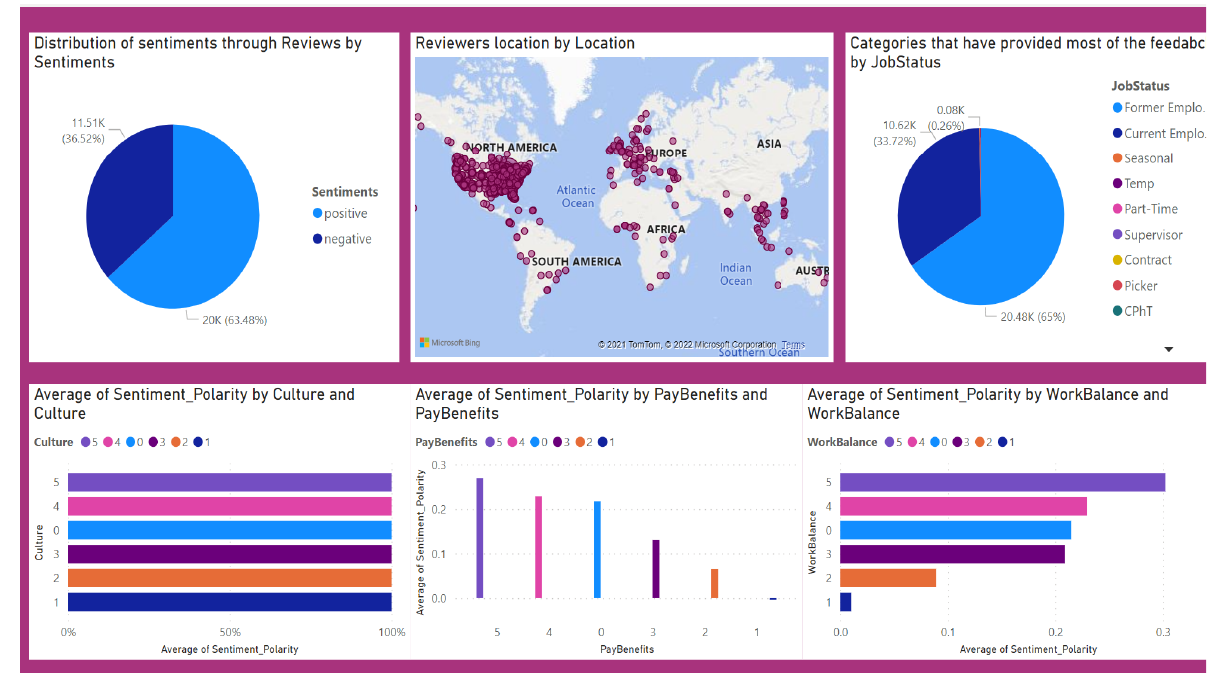
Figure 8. Dashboard of sentiment distribution obtained from enhanced dataset.